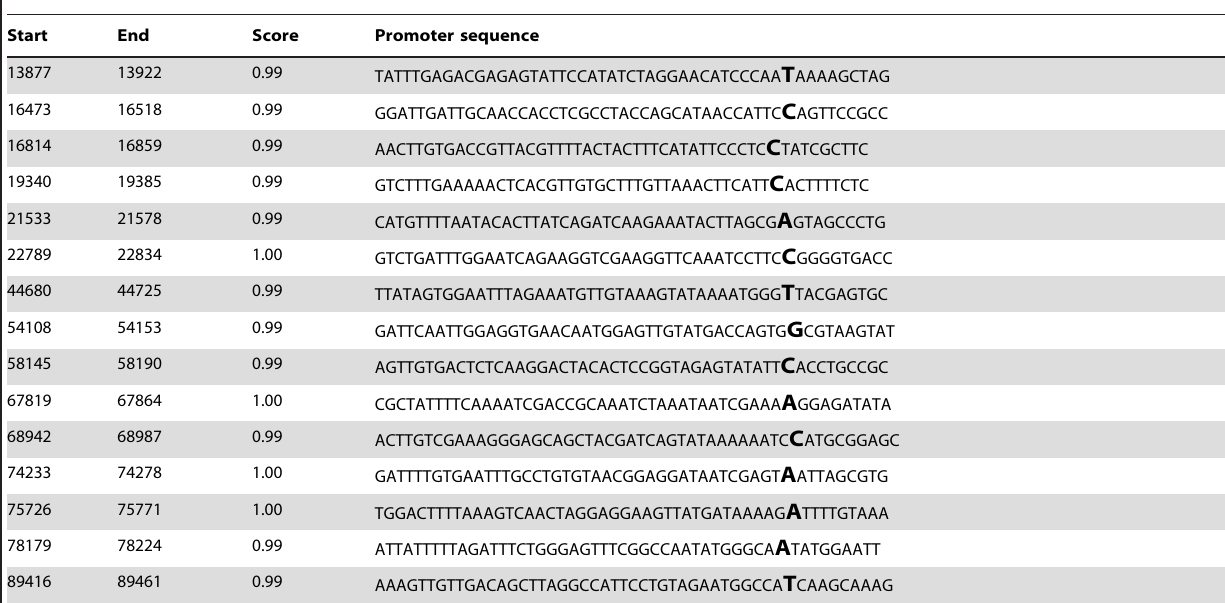
Table 2. Predicted promoters of the PaP1